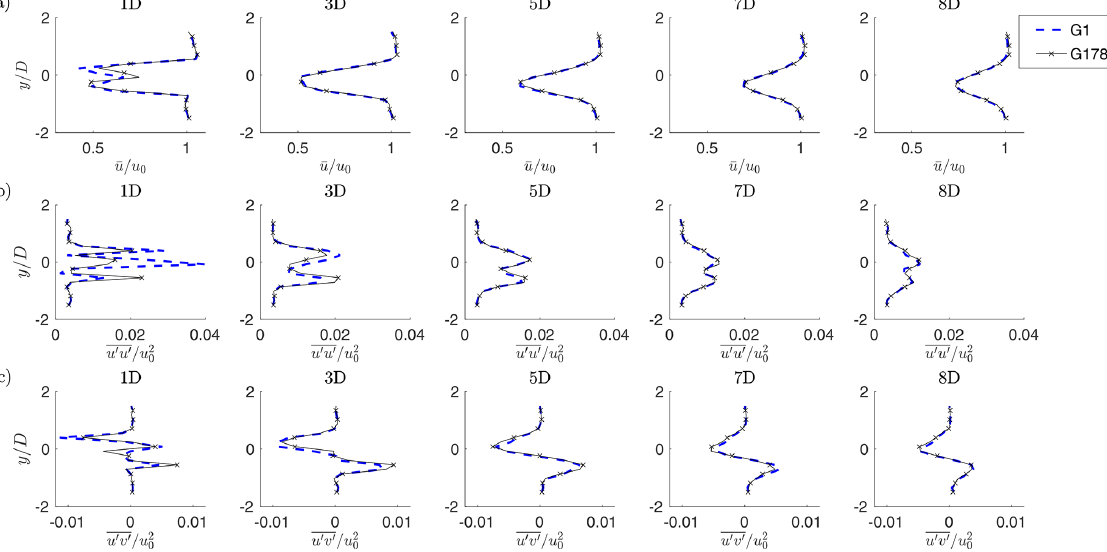
Figure 10. Hub-height profiles of normalized time-average streamwise velocity (a) , normal stress (b) and shear stress (c) , in the misaligned and medium-TI